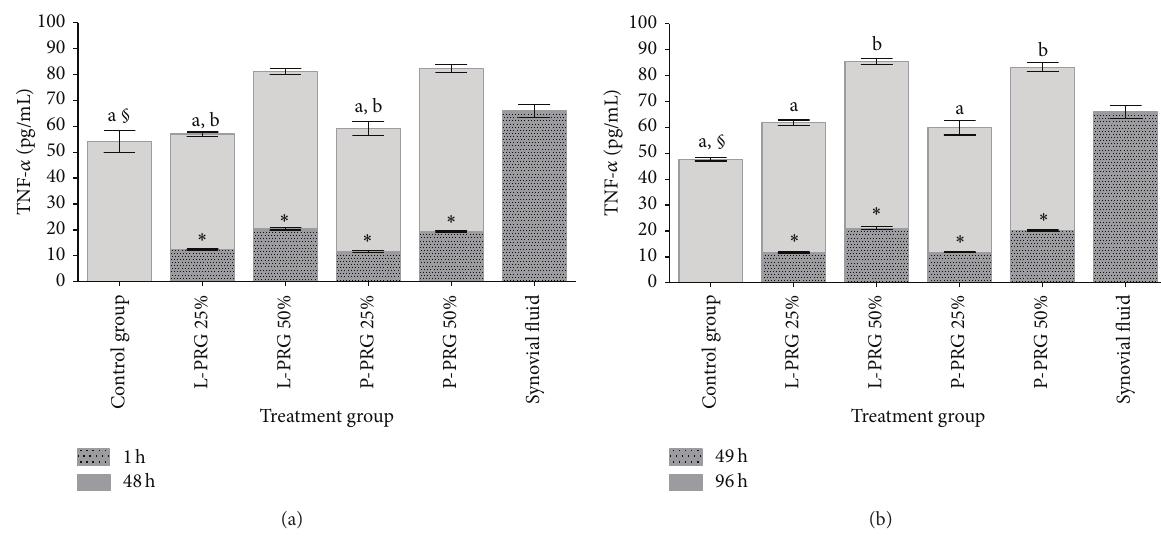
Figure 3: (a) a-b Lowercase letters denote significant ( 𝑃 < 0.05 ) differences between groups in the same column by Tukey test at 48 h. Significantly different with a: SF and b: L-PRG 50% and P-PRG 50%. (b) a-b Lowercase letters denote significant ( 𝑃 < 0.05 ) differences between groups in the same column by Tukey test at 96 h. Significantly different with a: SF and b: control group, L-PRG 25% and P-PRG 25%. ∗ Significant differences ( 𝑃 < 0.05 ) between the same variable at 1h and 48h and at 49h and 96 by 𝑡 -paired test. § Significant differences ( 𝑃 < 0.05 ) between the same variable at 48 and 96 h by Tukey